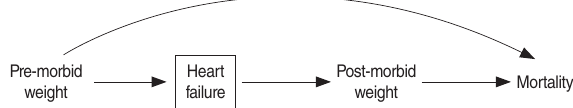
Figure 1. Directed acyclic graph representing the relationships of pre-morbid and post-morbid weight with mortality. The square box indicates that the study focused on heart failure.